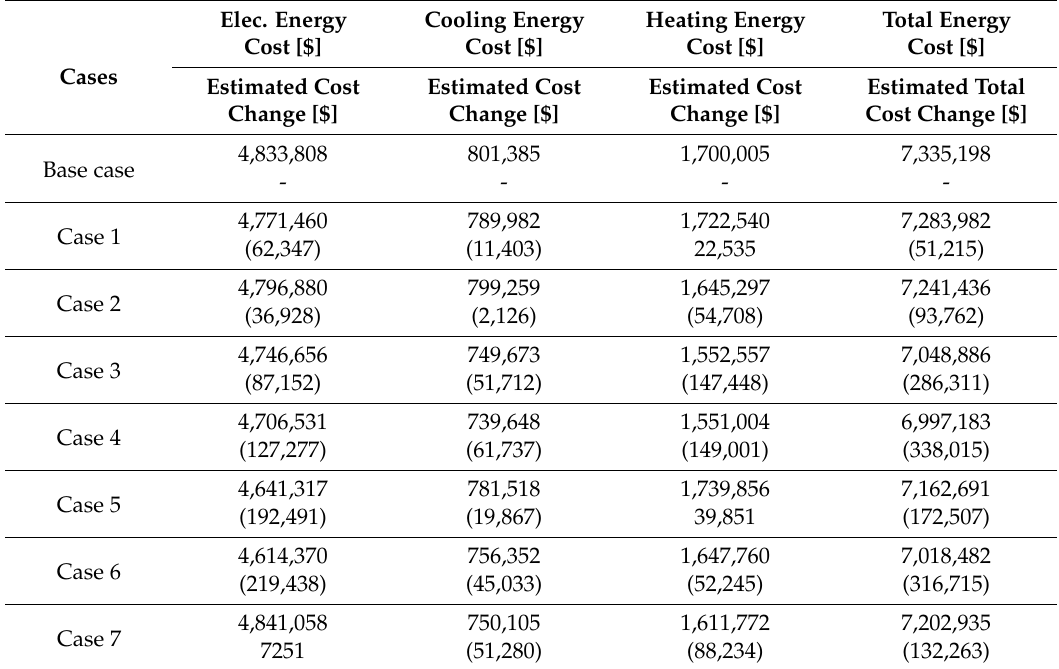
Table 8. Utility cost saving by each ECM based on 2011 energy prices.